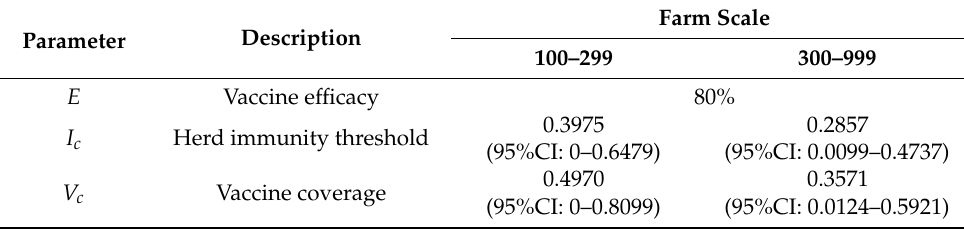
Table 4. Parameter estimation for vaccine coverage